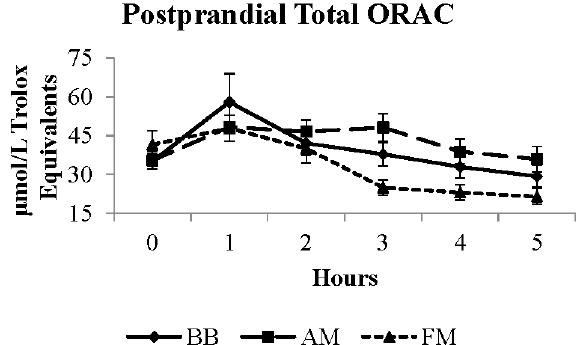
Figure 3. Postprandial total ORAC response to moderate-fat breakfast with BB, AM, or FM. BB, black bean meal; FM, fiber matched meal; AM, antioxidant matched meal; ORAC, oxygen radical absorbance capacity.